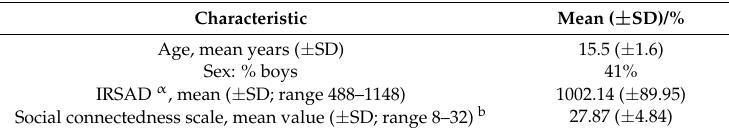
Table 1. Participant demographics ( n = 429).